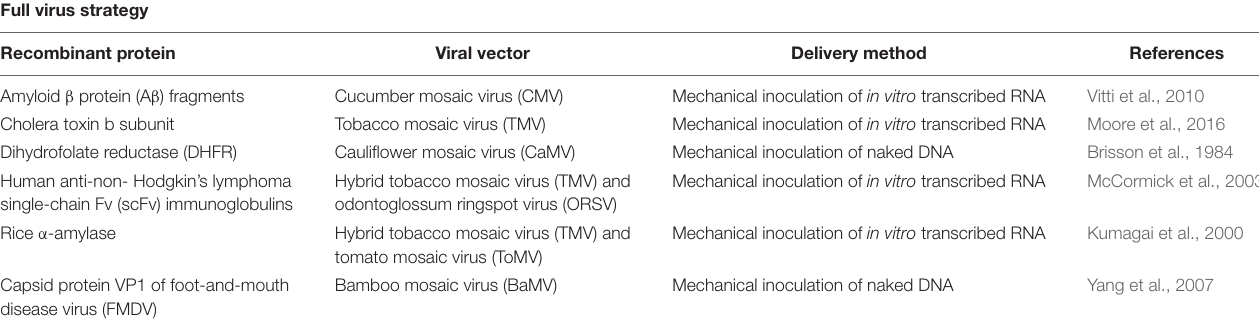
FIGURE 1 | Genomic organization and expression strategy of TMV and different strategies adapted to express recombinant protein or heterologous epitope using the full virus genome. (A) The positive single-stranded RNA genome has four separate ORF(s) with a 5 (cid:48) terminus methylated nucleotide cap (m7G5’pppG) and 3 (cid:48) -terminus tRNA-like structure. The first two 5 (cid:48) proximal ORF(s) encode 126 and 183 kDa readthrough proteins containing methyltransferase (MET), helicase (HEL), and polymerase (POL) domains which are involved in replication and transcription of the genome. ORF 3 and 4 are translated from separate subgenomic promoters and encode the 30 kDa movement protein (MP) and 17 kDa coat protein (CP) respectively. (B) Recombinant protein (RP) fused to the CP N-terminus using fusion peptide (FP) (Roder et al., 2017). (C) Recombinant epitope (RE) fused to the CP C-terminus using leaky UAG stop codon (Sugiyama et al., 1995). (D) Coding region of RP cloned in place of the virus CP gene (Takamatsu et al., 1987). (E) Coding region of RP downstream a subgenomic RNA promoter and placed between the MP and the CP genes (Dawson et al., 1989). (F) Coding region of RP cloned downstream TMV subgenomic RNA promoter and placed between TMV MP gene and a heterogeneous CP (H-CP) gene. The latter was cloned into the TMV vector together with its heterogeneous subgenomic promoter from odontoglossum ringspot virus (ORSV) (Donson et al., 1991). TABLE 1 | Plant-made proteins expressed using full viral